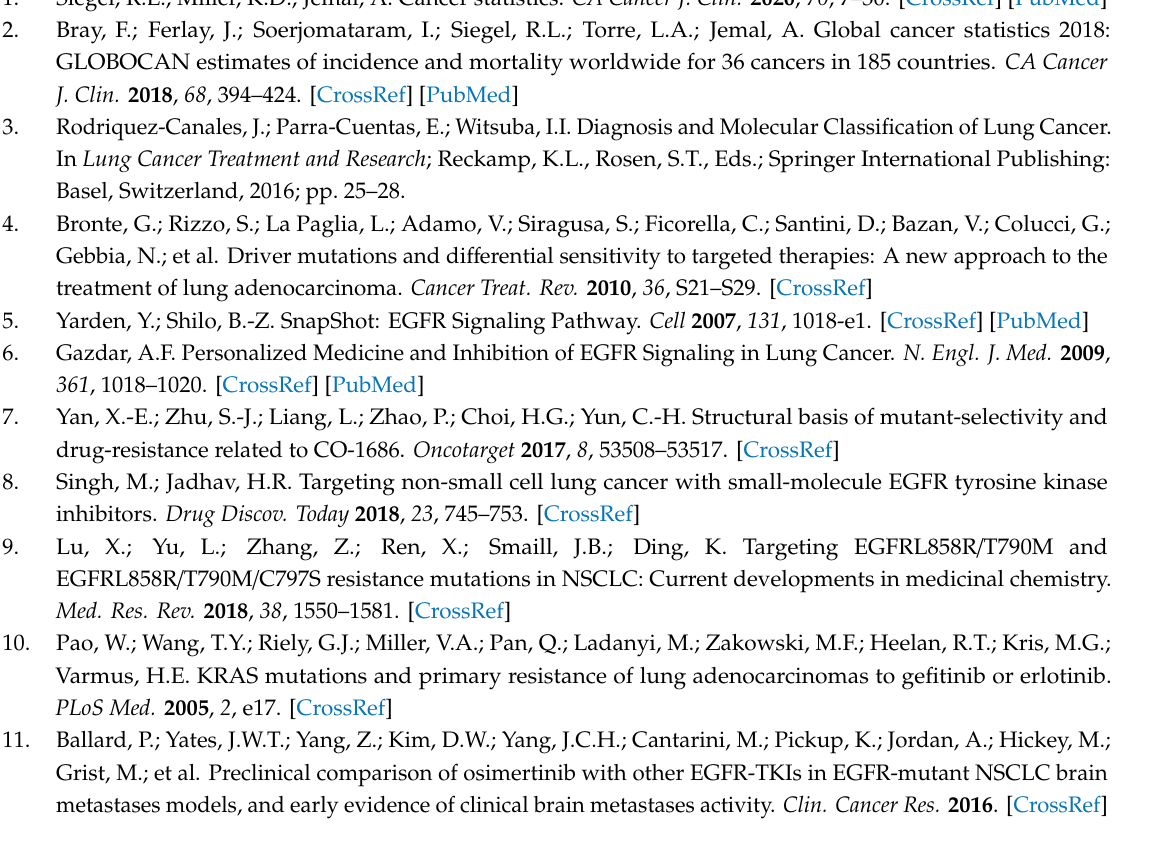
Figure S1: The proton and carbon NMR peak of 1-iodo-3,5-dinitrobenzene ( 1 ), Figure S2: The proton and carbon NMR peak of 5-iodobenzene-1,3-diamine ( 2 ), Figure S3: The proton and carbon NMR peak of tert-butyl (3-amino-5-iodophenyl)carbamate ( 3 ), Figure S4: The proton and carbon NMR peak of tert-butyl (3-((2-chloro-5-(trifluoromethyl)pyrimidin-4-yl)amino)-5-iodophenyl)carbamate ( 4 ), Figure S5: The proton and carbon NMR peak of N -(3-((2-chloro-5-(trifluoromethyl)pyrimidin-4-yl)amino)-5-iodophenyl) acrylamide ( 5 ), Figure S6: The proton and carbon NMR peak of 4-fluoro-2-methoxy-1-nitrobenzene ( 6 ), Figure S7: The proton and carbon NMR peak of 1-(piperazine-1-yl)ethan-1-one ( 7 ), Figure S8: The proton and carbon NMR peak of 1-(4-(3-methoxy-4-nitrophenyl)piperazine-1-yl)ethan-1-one ( 8 ), Figure S9: The proton NMR peak of 1-(4-(4-amino-3-methoxyphenyl)piperazine-1-yl)ethan-1-one ( 9 ), Figure S10: The proton and carbon NMR peak of N -(3-((2-((4-(4-acetylpiperazin-1-yl)-2-methoxyphenyl)amino)-5-(trifluoromethyl)pyrimidin-4-yl)amino)-5- iodophenyl)acrylamide ( 10 ), Figure S11: The proton NMR peak of N -(3-((2-((4-(4-acetylpiperazin-1-yl)-2- methoxyphenyl)amino)-5-(trifluoromethyl)pyrimidin-4-yl)amino)-5-(tributylstannyl) phenyl) acrylamide ( 11 ), Figure S12: The chromatograms of (a) nonradioactive iodinated compound 10 (ICO1686) and (b) radioactive compound [ 125 I] 10 ([ 125 I]ICO1686), Figure S13: The stability of radiolabeled compound [ 125 I] 10 in PBS and